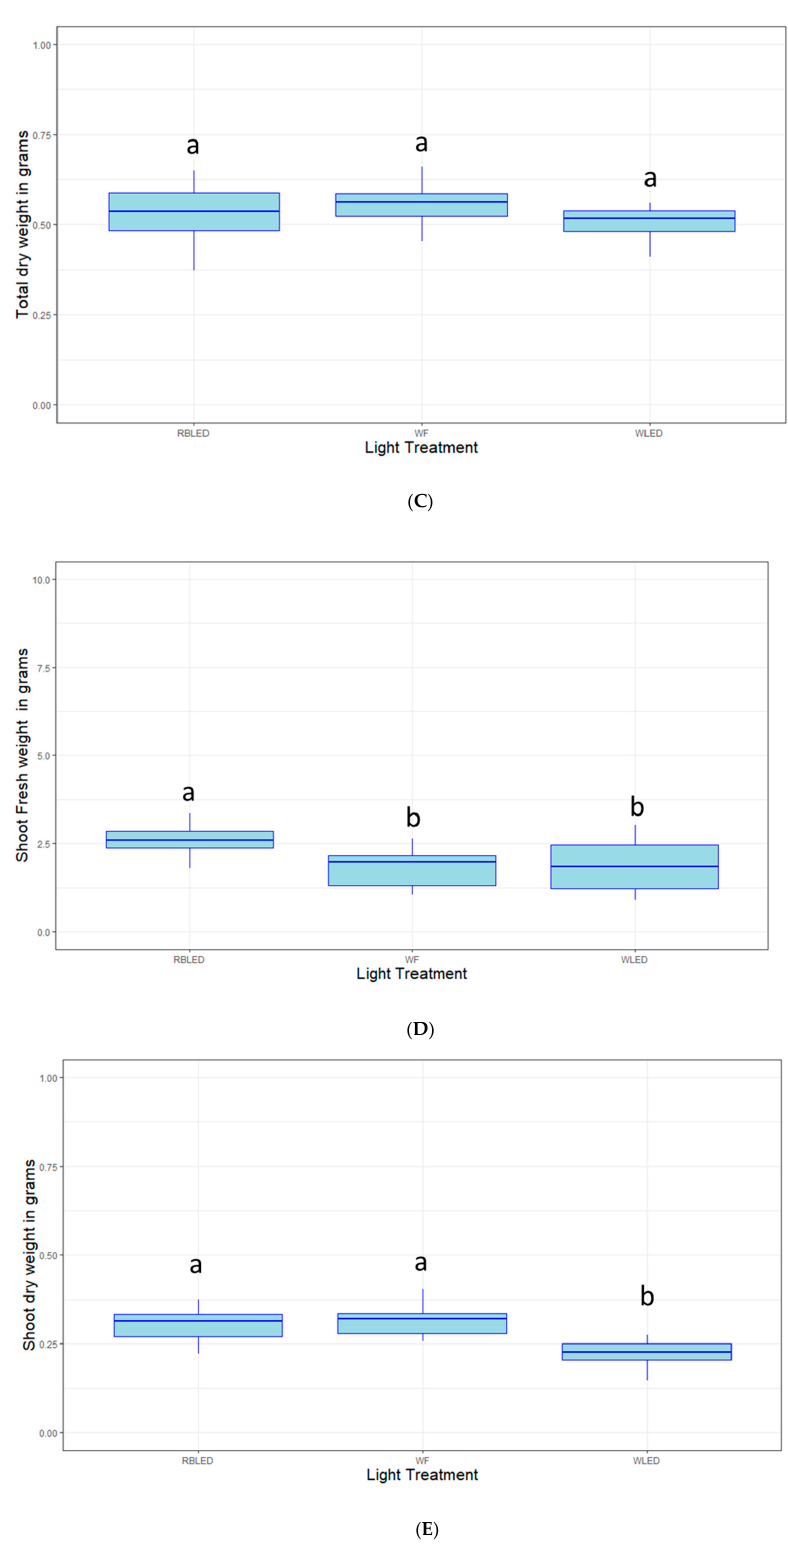
Figure 4. Box plot distribution of the effect of Red-Blue LED (RBLED), White Fluorescent (WF) and White LED (WLED) light sources on ( A ) shoot proliferation; ( B ) total fresh weight of callus and stems; ( C ) fresh weight of stems only; ( D ) dry weight of calli and stems; ( E ) dry weight of stems only. These